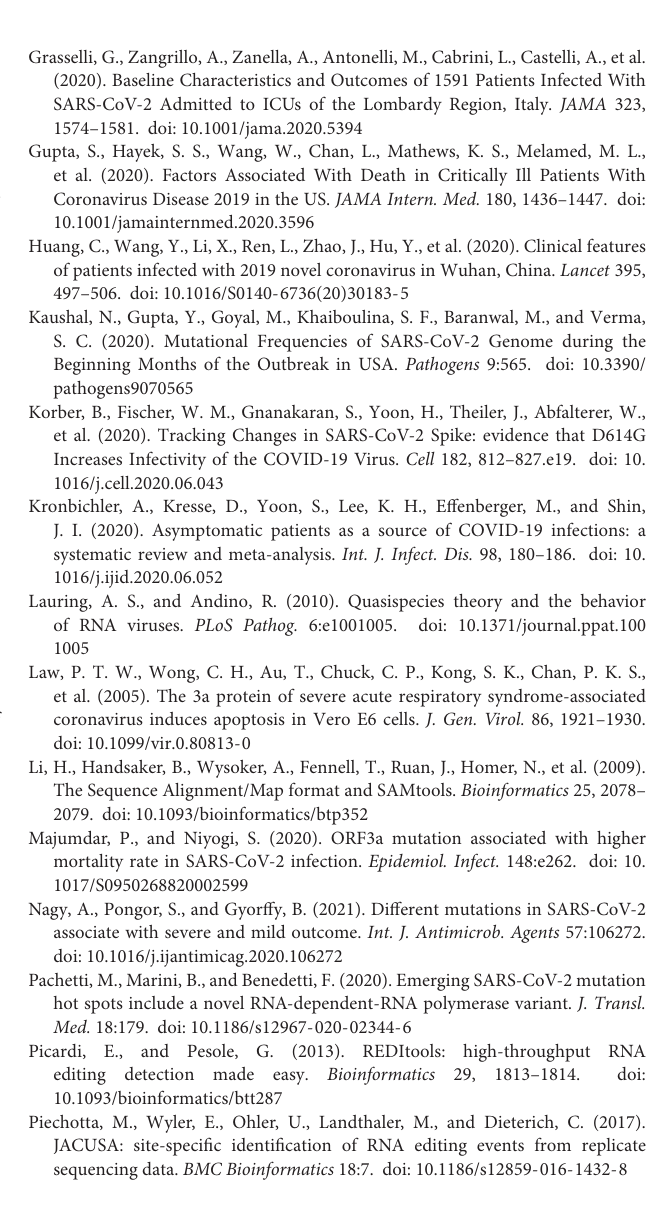
Supplementary Figure 2 | Motif of different SNV types in SARS-CoV-2 among different clinical outcomes. Supplementary Figure 3 | Distribution of all SNV types among different samples. Supplementary Figure 4 | Analysis of expression of RNA-editing enzyme in the transcriptome. (A–C) Expression of RNA-editing enzyme after SARS-CoV-2 infection and other infection from nasopharyngeal swabs. (D–F) Expression of RNA-editing enzyme in the three clinical outcomes from nasopharyngeal swabs. (G–L) Correlation of expression levels of ADARB2, APOBEC2, APOBEC3A, APOBEC4, ROMO1, and NRROS with SARS-CoV-2 virus load. ∗ p < 0.05, ∗∗ p < 0.01, ∗∗∗ p <